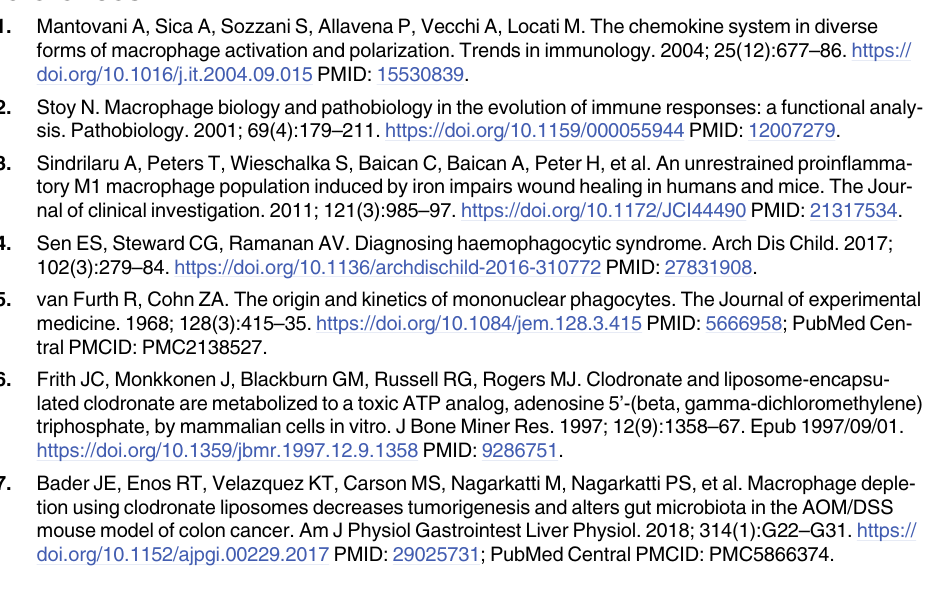
Fig 2. Effect of liposomal clodronate on macrophages in vitro and in vivo . (A) The viability of mouse macrophage-like RAW264.7 cells after liposomal clodronate (lipo-CL2MDP) treatment (48 hours) was evaluated using a colorimetric assay. Liposomal PBS (lipo-PBS) was used as a control. The percentage viability was calculated as follows: (OD value in the presence of each concentration of lipo-CL2MDP or lipo-PBS/OD value with no additive) × 100. The results reflect the mean ± SD of three independent determinations (representative experiment of three performed). The asterisk denotes statistical significance ( � P < .05). (B) The effects of lipo-CL2MDP on macrophages injected into mice were analyzed by an image analyzer. Lipo-CL2MDP or lipo-PBS was administered into mice 3 hours after the injection of macrophages labeled with XenoLight DiR 1 . The time course of total fluorescence signal intensities was evaluated for 168 hours. The asterisk denotes statistical significance ( � P < .05). (C) Lipo-CL2MDP or lipo-PBS was administered into mice 3 hours after the injection of macrophages labeled with XenoLight DiR 1 . The fluorescence signal intensities in different organs were compared after 7 days. Labeled macrophages home specifically in the liver, spleen and lung (upper panel). However, in the subgroup treated with lipo-CL2MDP (lower panel), fluorescence signal was detected slightly (liver and spleen) and minimally (lung). Scale bar, 10 mm. (D) Pathological assessment of macrophages after lipo-CL2MDP treatment. Liver (left panels), spleen (middle panels) and lung (right panels) specimens were stained with H&E (top panels in each subgroup) and the macrophages were detected with the anti-mouse F4/80 monoclonal antibody (bottom panels in each subgroup). Representative images of three mice are shown. Original magnification, × 400. Scale bar, 80 μ